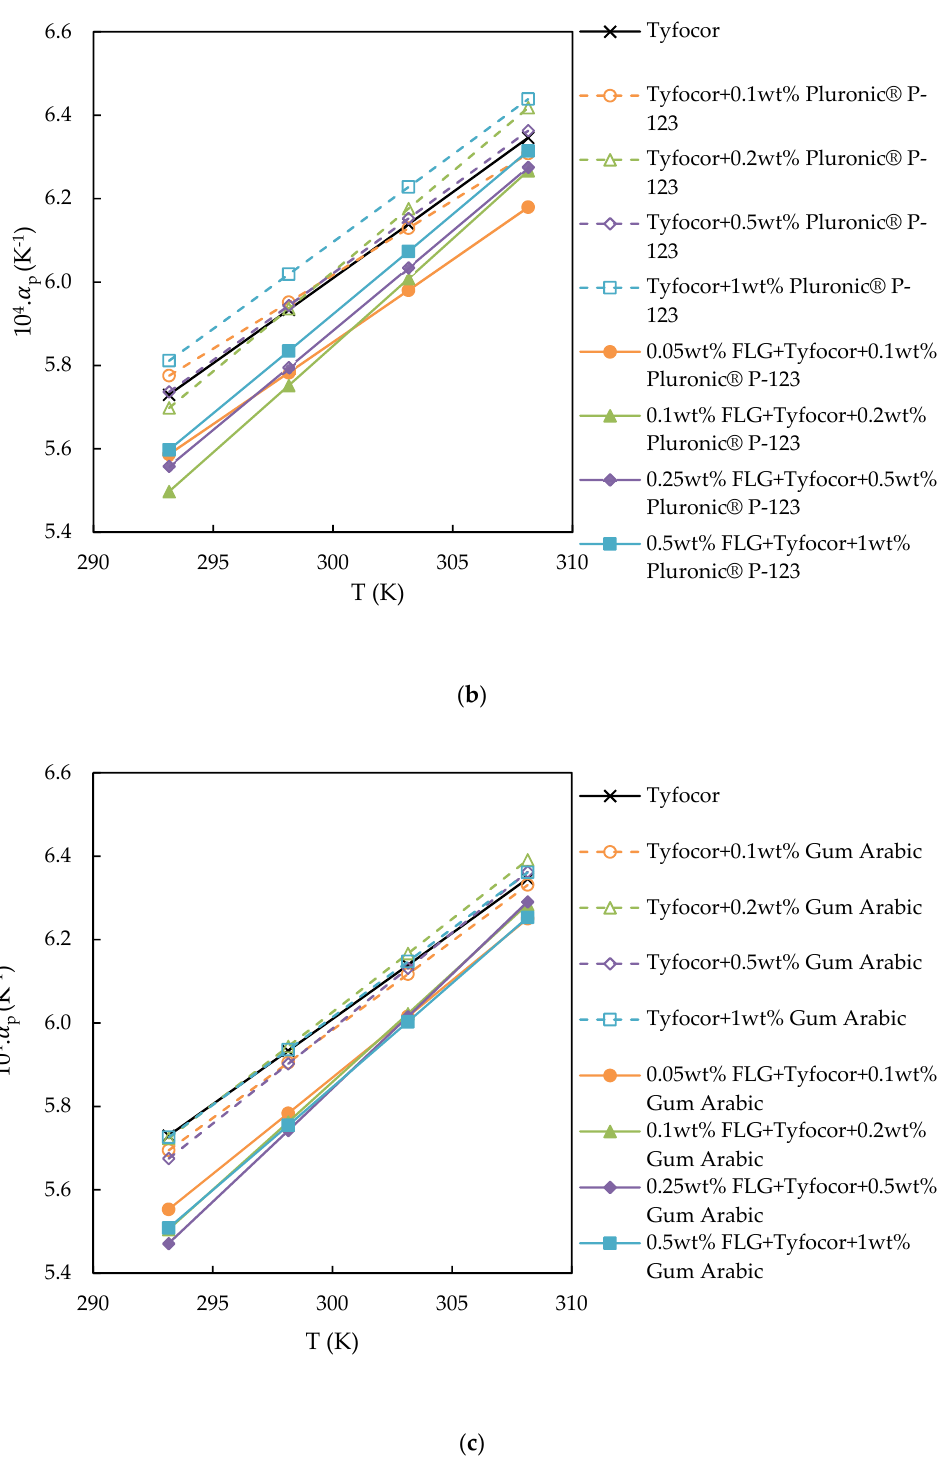
Figure 4. Variation of the isobaric thermal expansivity, α p , as a function of temperature of both base fluids and nanofluids series prepared with ( a ) Triton X-100, ( b ) Pluronic ® P-123 and ( c ) Gum Arabic.